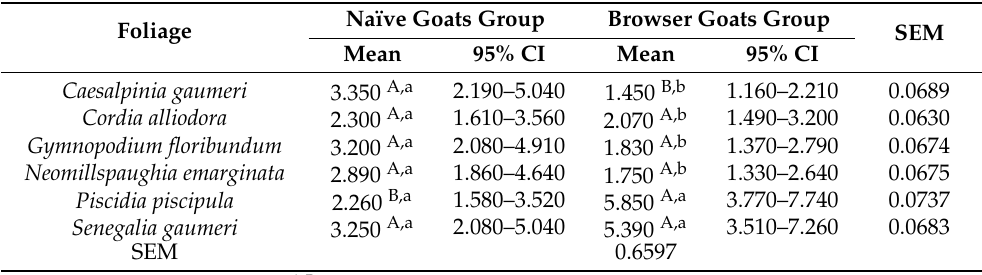
Table 3. Effect of browsing experience of juvenile goats on dry matter intake (g DM/kg 0.75 ) and 95% confidence intervals (95% CI) of the six forage resources evaluated in the cafeteria trial lasting six days of observations (30